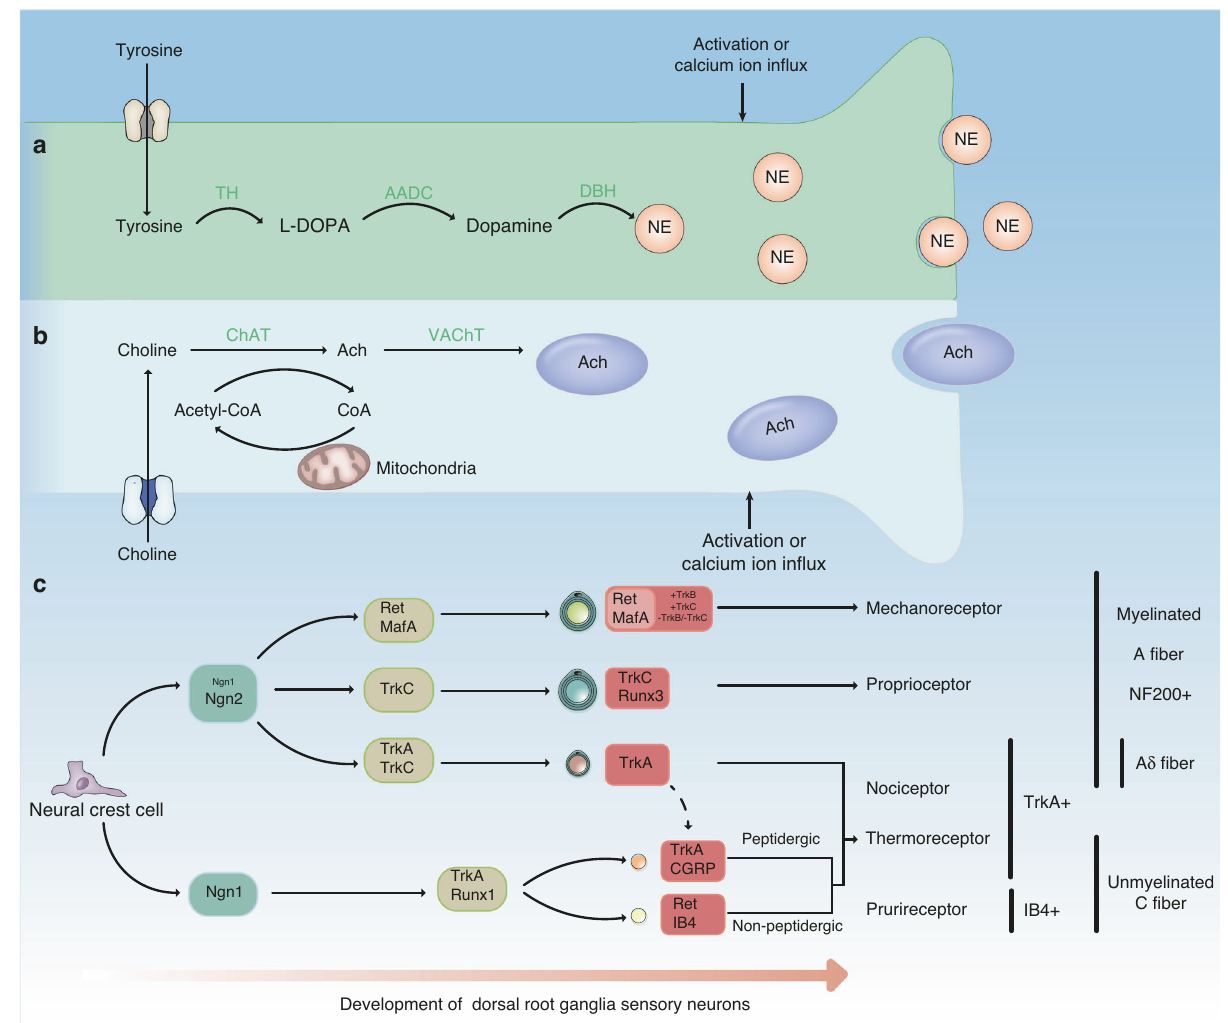
Fig. 2 Main biomarkers of the ANS and sensory nerves. a Norepinephrine (NE) is synthesized from tyrosine by a multienzyme pathway. Tyrosine hydroxylase (TH) converts tyrosine to L-DOPA. L-Aromatic amino acid decarboxylase (AADC) converts L-DOPA into dopamine, which is fi nally hydroxylated by DA- β -hydroxylase (DBH) to produce NE. b Acetylcholine (ACh) is synthesized from choline and acetyl coenzyme A (acetyl-CoA) with catalysis by choline acetyltransferase (ChAT), and then vesicular ACh transporter (VAChT) stores ACh in vesicles. c Development of DRG sensory neurons. All DRG sensory neurons develop from neural crest cells and gradually differentiate into different lineages with sophisticated regulation, which is not fully understood. Finally, after progressive diversi fi cation, these immature neurons develop into various sensory neurons that transduce different kinds of sensation, including mechanoreceptors, proprioceptors, nociceptors, thermoreceptors and pruriceptors (sensitive to histamine-independent itch). The length of short vertical lines marked with speci fi c biomarkers on the right corresponds to the different lineages on the left. The most representative expression of this lineage during development is marked in boxes. The horizontal axis shows the relative development of DRG neurons, which means that Ngn1 + neurons are late developers. Dotted lines indicate deductions. Ngn1 Neurogenin-1, Ngn2 Neurogenin-2, TrkA Tropomyosin receptor kinase A, NF200 Neuro fi lament 200, IB4 Isolectin ossi fi cation center of the mandible is just adjacent to the nerve bundle, extending along the inferior alveolar nerve. 86 Genetic disruption of TrkA signaling in sensory nerves leads to early closure of cranial sutures. 87 Generally, peripheral nerves are thought to accompany blood vessels, 88 and this holds true in mature bones. Sensory nerves, as well as the SNS, parallel the vascular structures to reach bone as a mixture of motor, sensory and sympathetic nerves. 89 The major nerves consist of mixed neural components innervating the periosteum in a meshwork pattern, 71 particularly the inner cambium layer, which possesses a high cell density consisting mainly of periosteum-derived MSCs, osteoclasts and osteo- blasts. 90,91 Through nutrient canals, vertical Haversian canals,